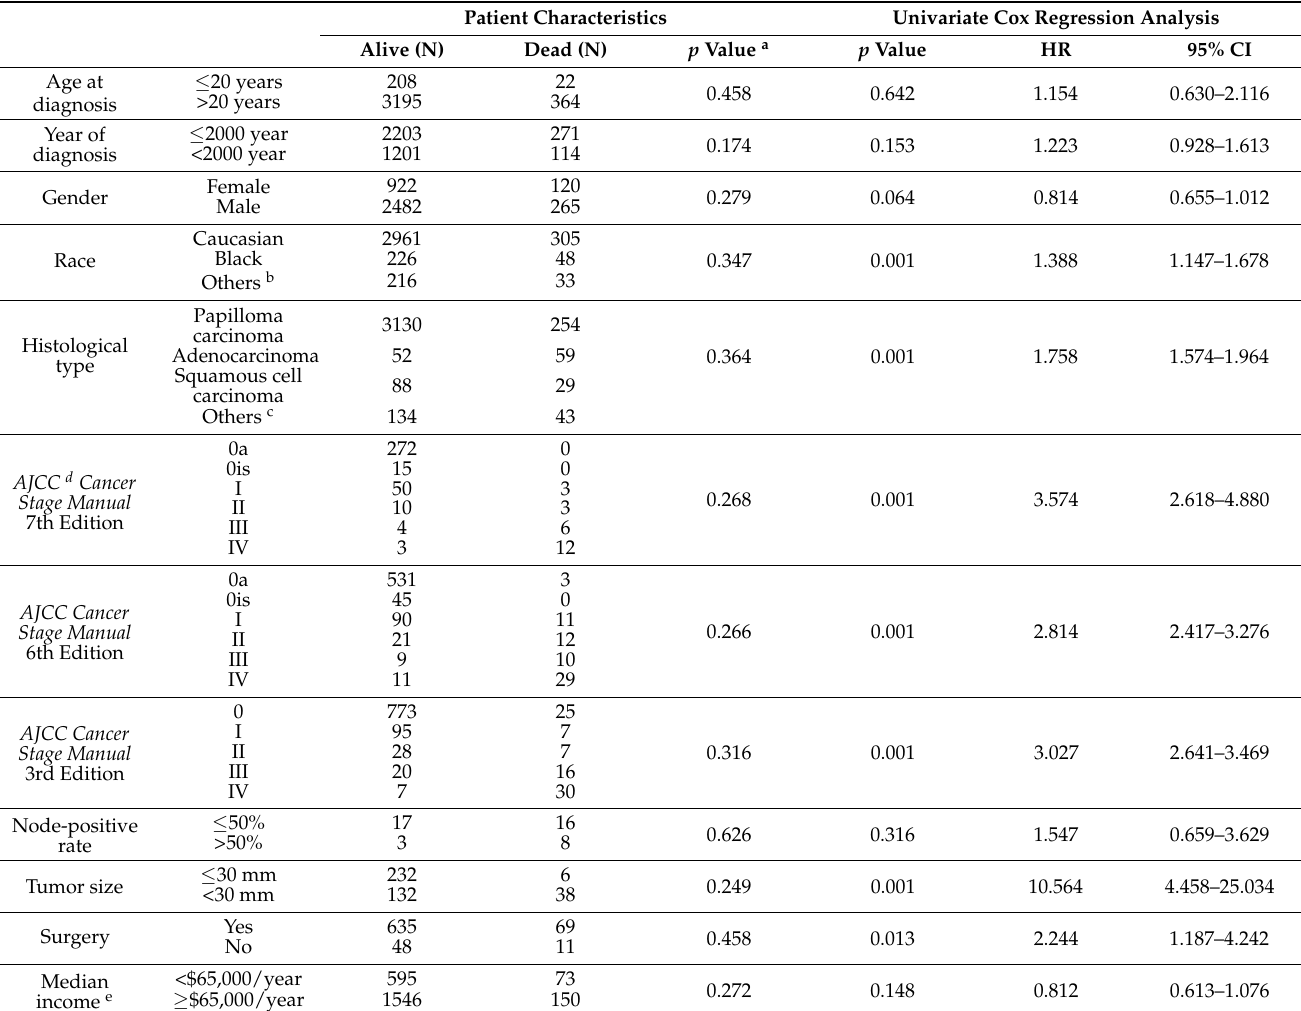
Table 1. Patient characteristics and univariate Cox regression analysis predicting cancer-specific